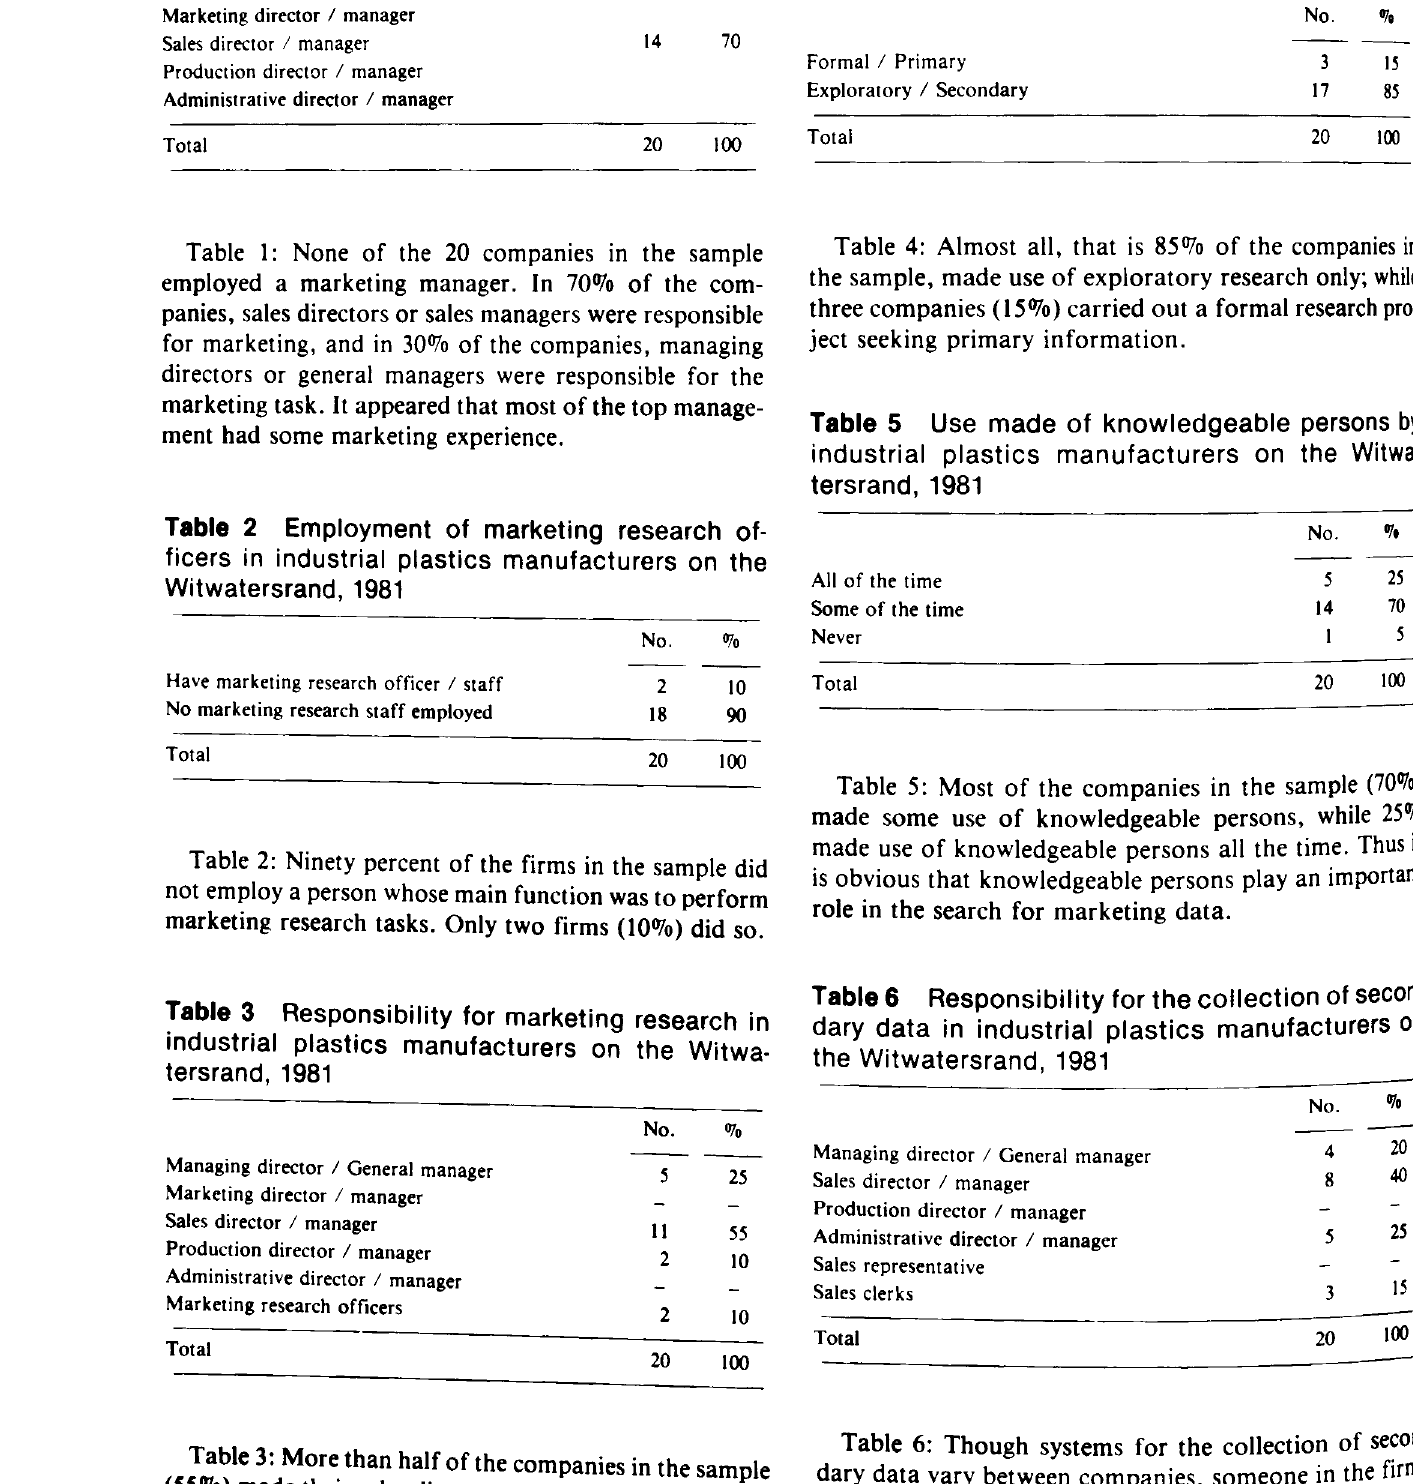
Table 6: Though systems for the collection of secon· dary data vary between companies, someone in the firms must be responsible for the collection of this data.